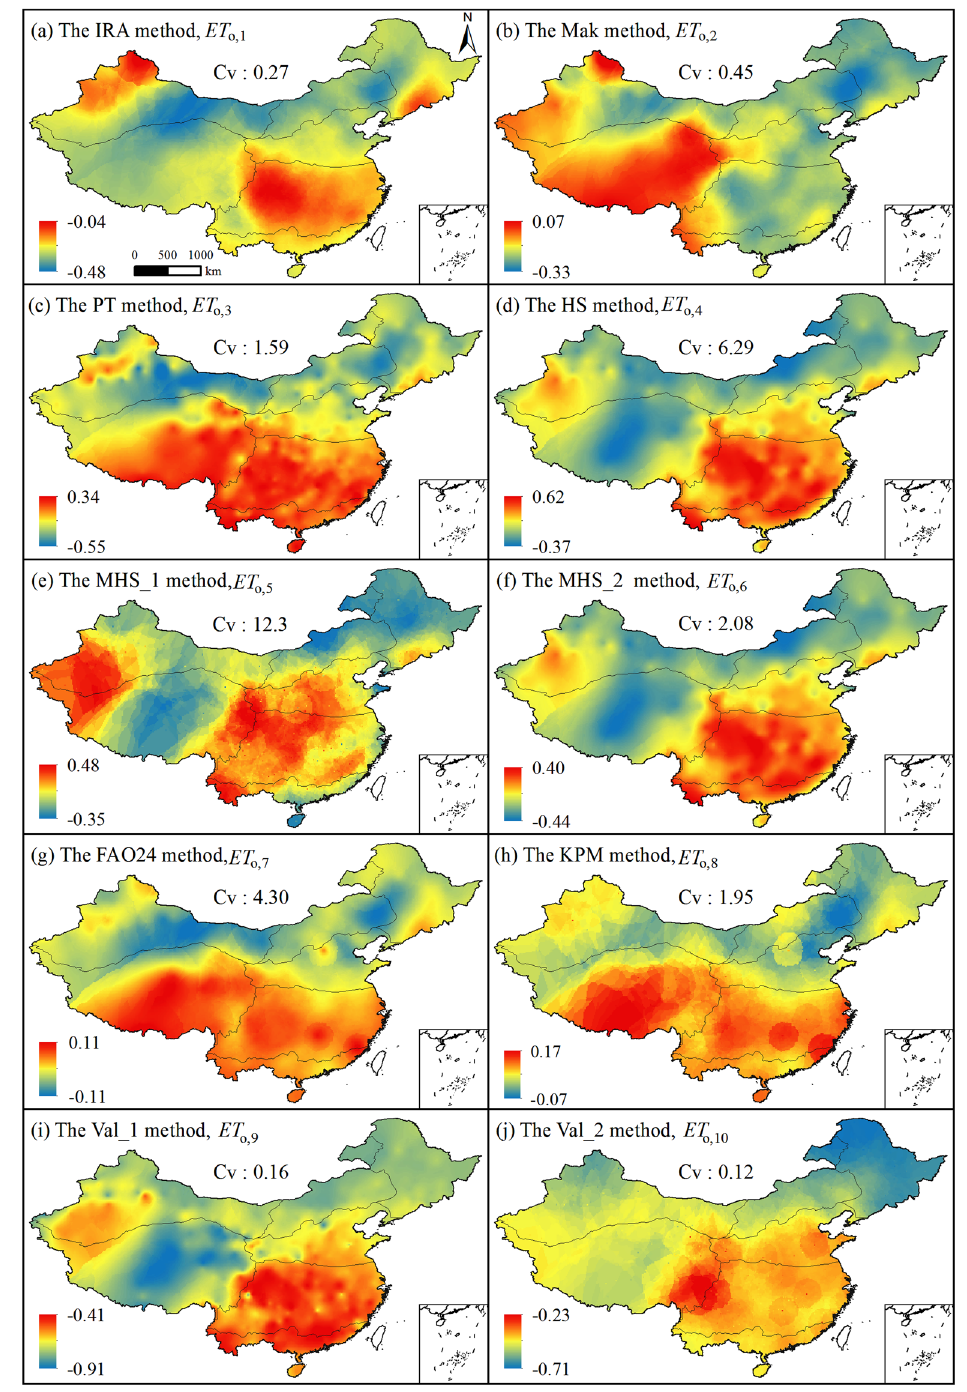
Figure 7. Spatial distribution of RE values for multi-year mean monthly ET o,i in EMC. (ArcGIS 10.2, http:// map.baidu.com, Lingling